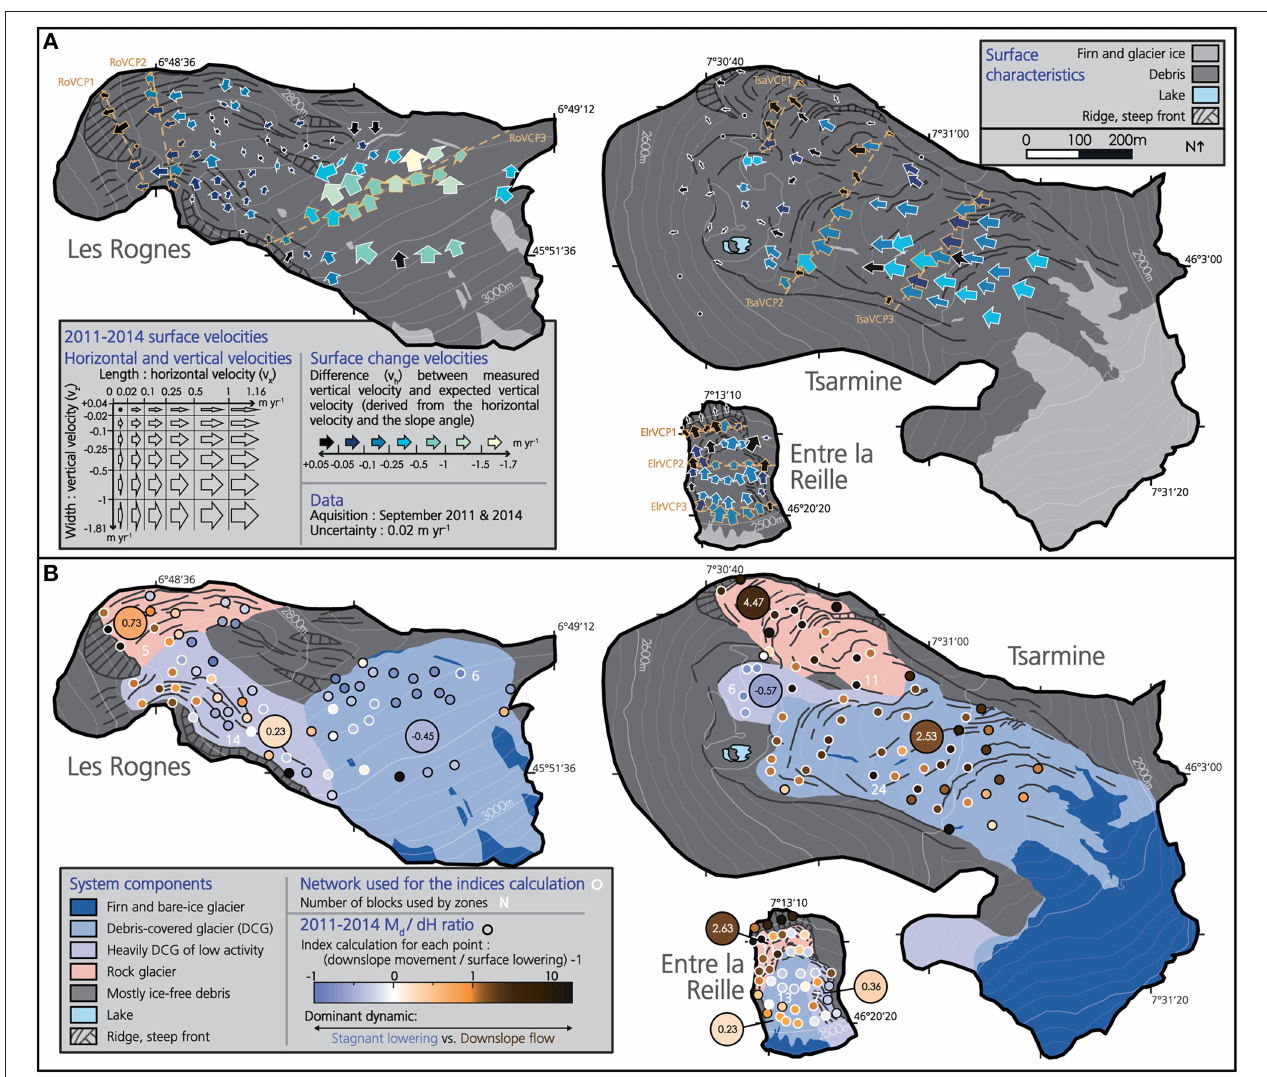
FIGURE 6 | (A) Velocities measured with dGPS in the study sites between September 2011 and 2014. Orange lines correspond to the velocity cross-profiles of Figure 8 where the horizontal velocity of the points in orange is depicted. (B) Components of the glacier systems and downslope movement/surface lowering (M d /dH) ratio results based on the movements measured between September 2011 and 2014 (A) . The large circles correspond to the mean M d /mean dH value by zone in each site. White circles correspond to the position of the dGPS network used for the calculation of the dynamical index in Figure 7